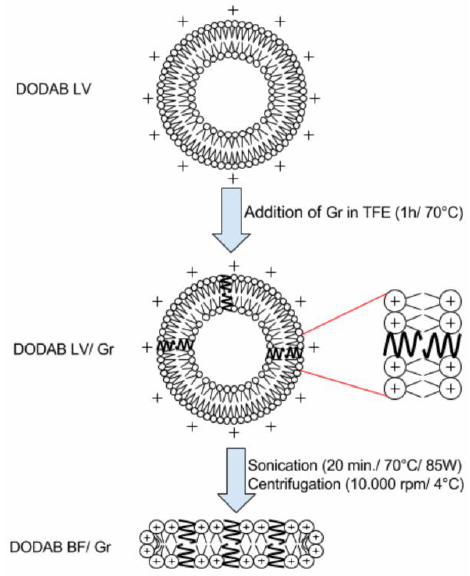
Table 2. MBC, in mM, and maximal reduction of cell viability, in log (CFU/mL), for DODAB in different assemblies against E. coli and S. aureus .